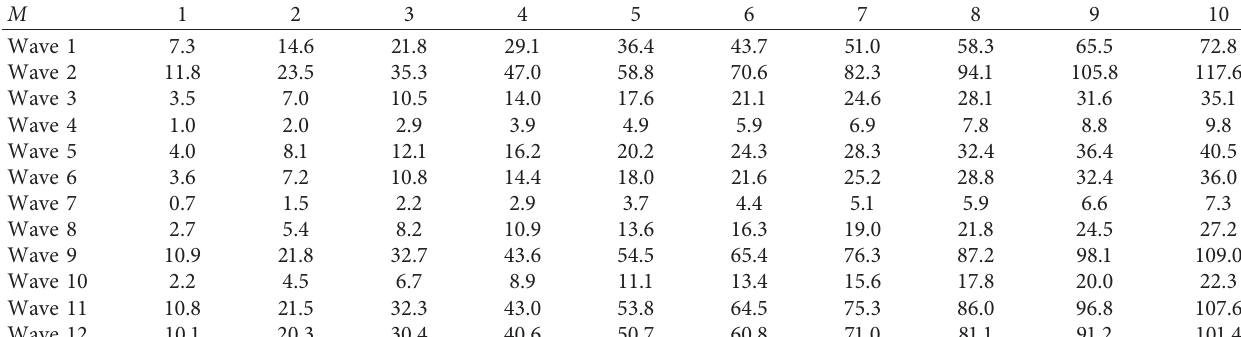
Table 4: Seismic waves amplitude modulation